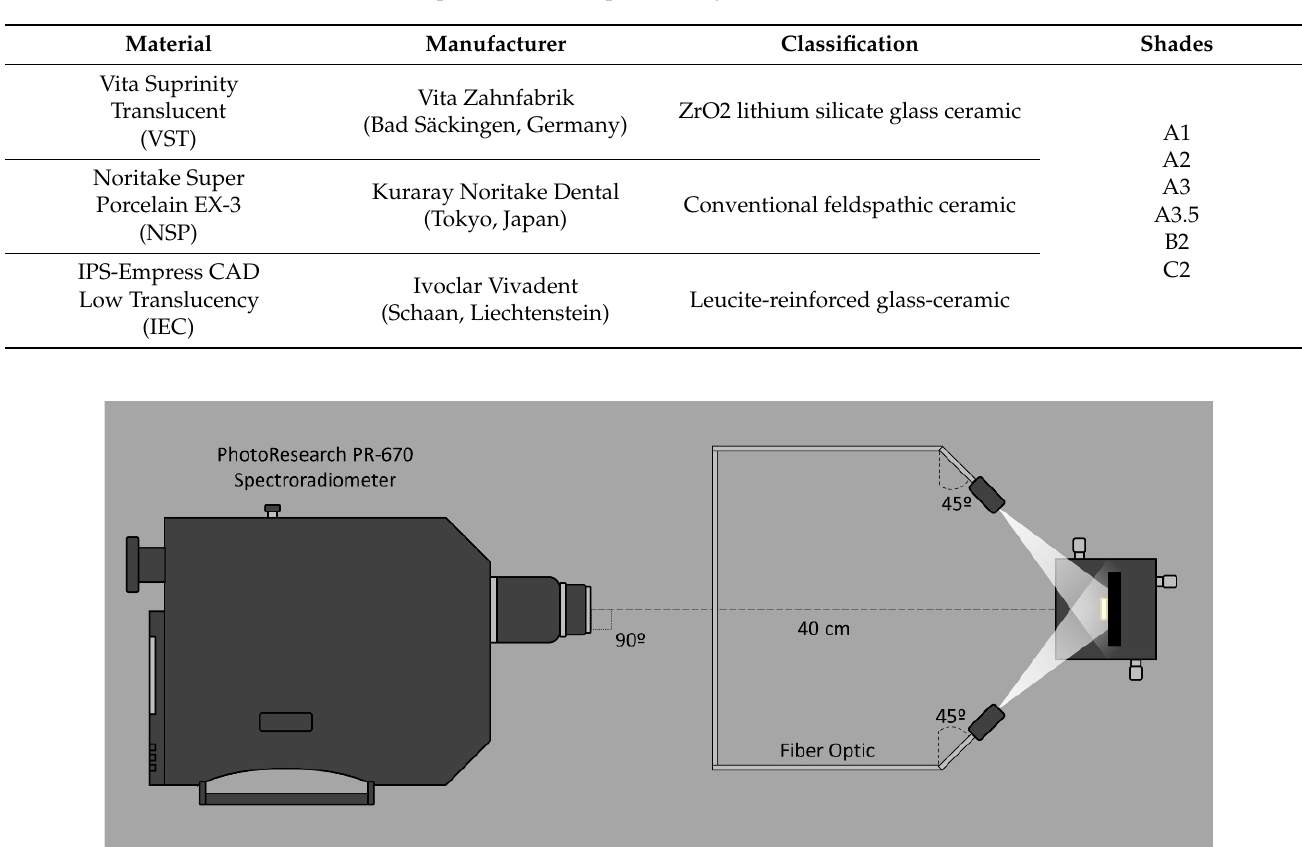
Figure 1. Experimental device configuration used for color measurements.